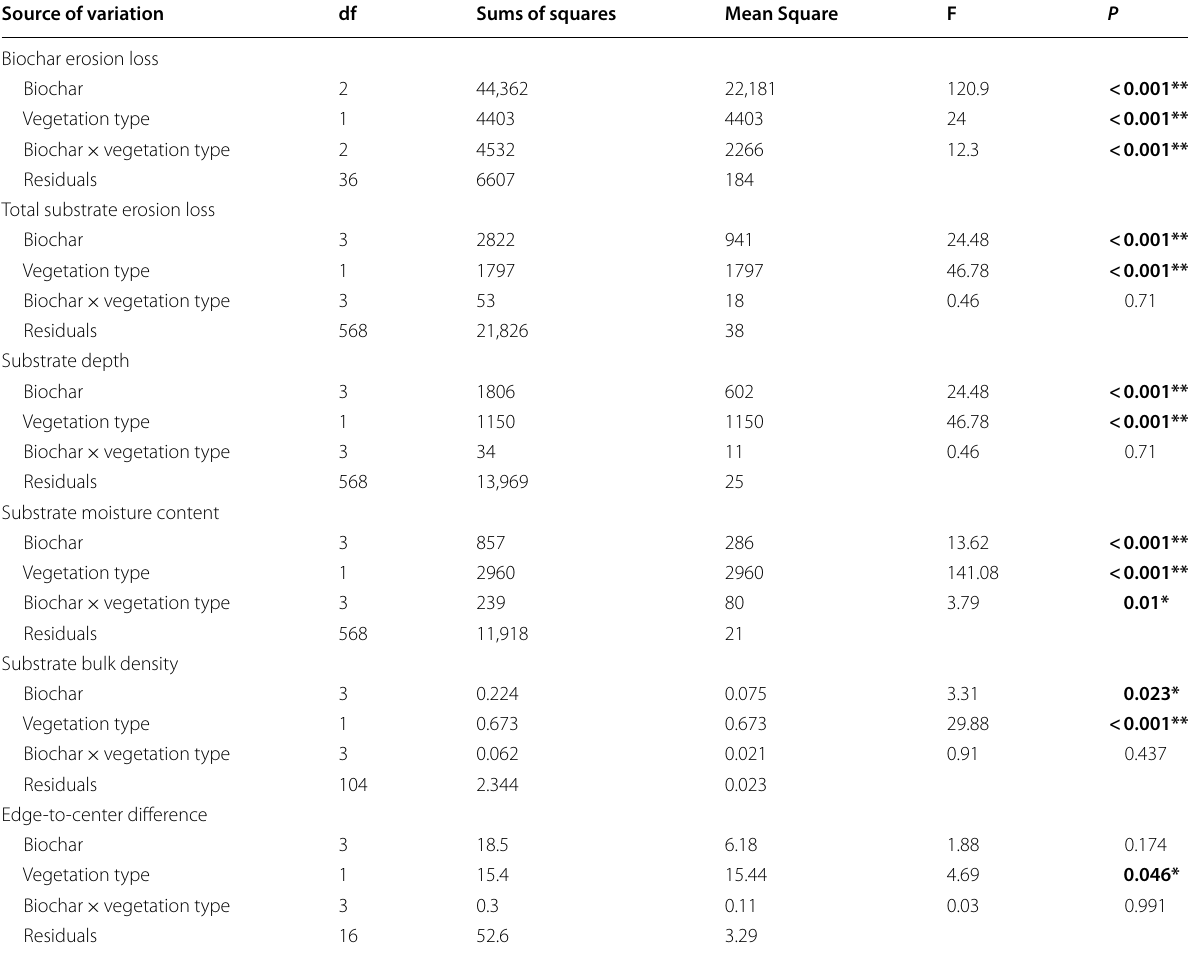
Asterisks indicate significance of two-way ANOVA: * P < 0.05; ** P < 0.01; *** P < 0.001 Statistically significant relationships ( P < 0.05) are in boldface